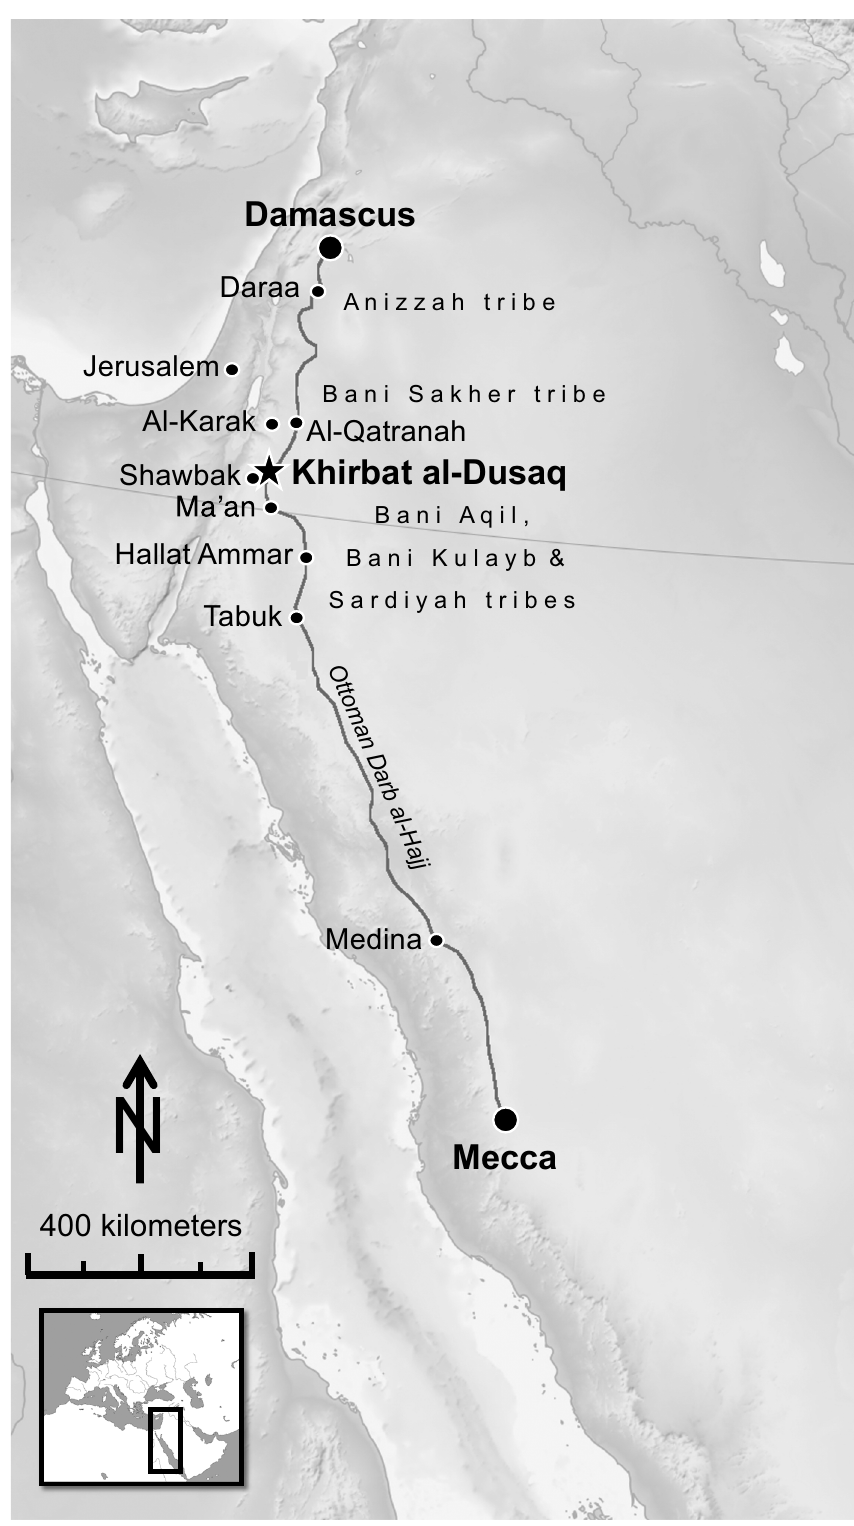
Figure 1: Map of the approximate path of the Ottoman Darb al - Hajj , also showing the localisation of the main sites mentioned in the text. Based on commons.wikimedia.org, reworked by Hofstetter ( 2022 )